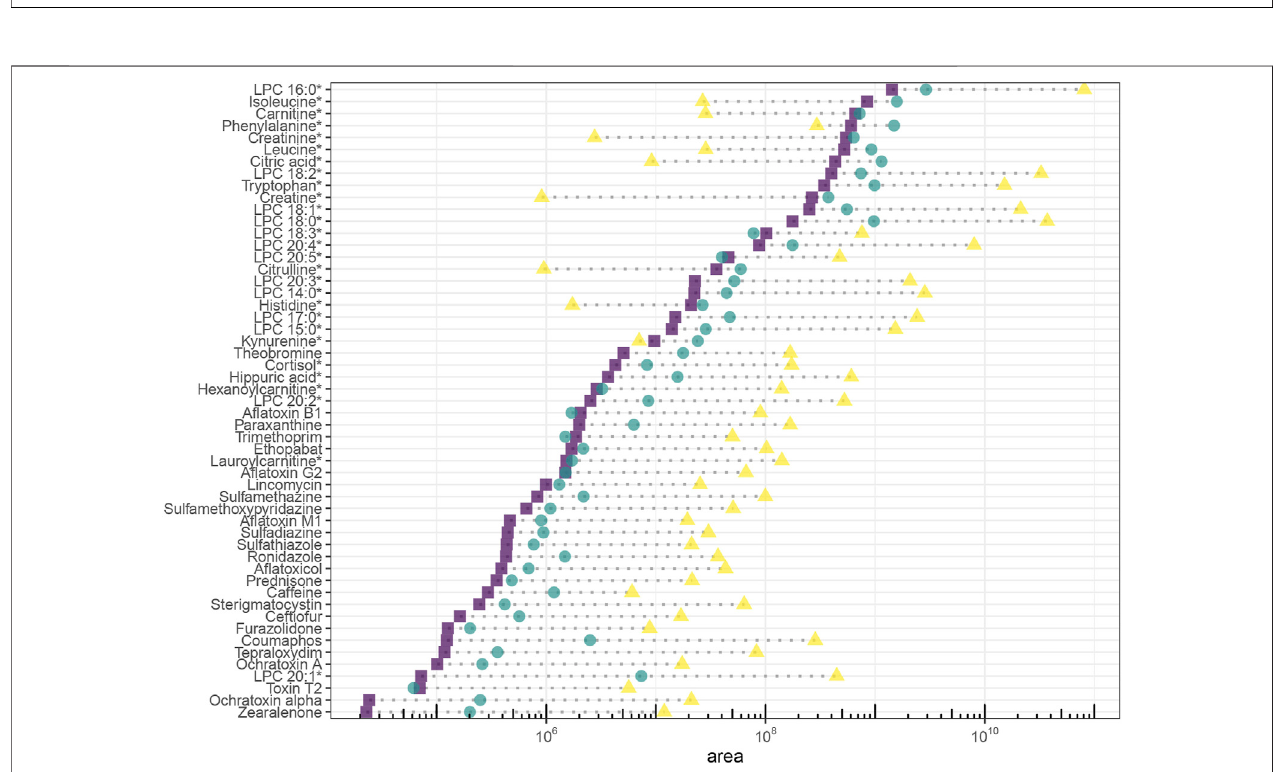
FIGURE 4 | Signal intensity of endogenous (natural abundance) and exogenous molecules (ceftiofur and coumaphos 10 μ g/L, caffeine, paraxanthine and theobromine naturally occuring abundance, all others 1 μ g/L) in plasma extract. Areas are background corrected. Endogenous molecules are marked with an asterisc.